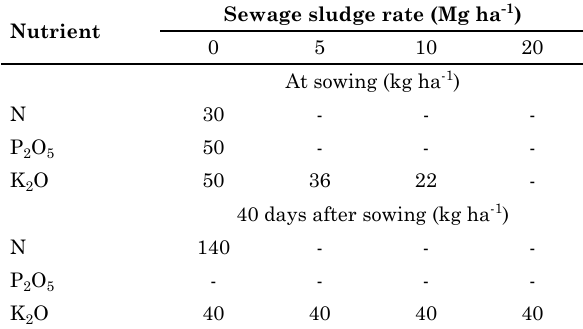
Table 4. Contents of N, P 2 o 5 and K 2 o applied to the treatments as mineral fertilizers in the 16 th year nutrient